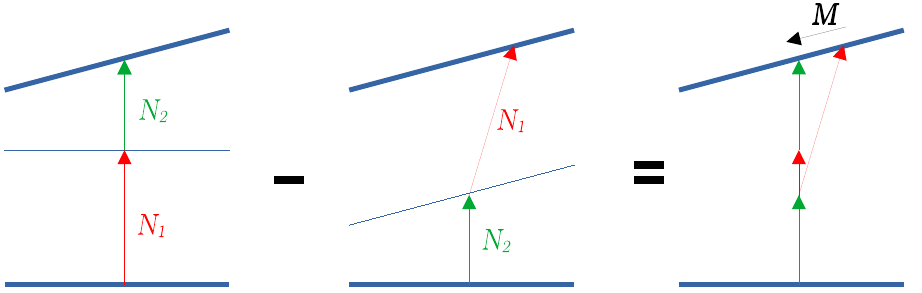
Figure 3. Semidirect product of time reparameterizations and inhomogeneous transformations as in (9), represented in the picture of hypersurface deformations: The commutator of two such normal deformations produces a non-zero spatial shift M